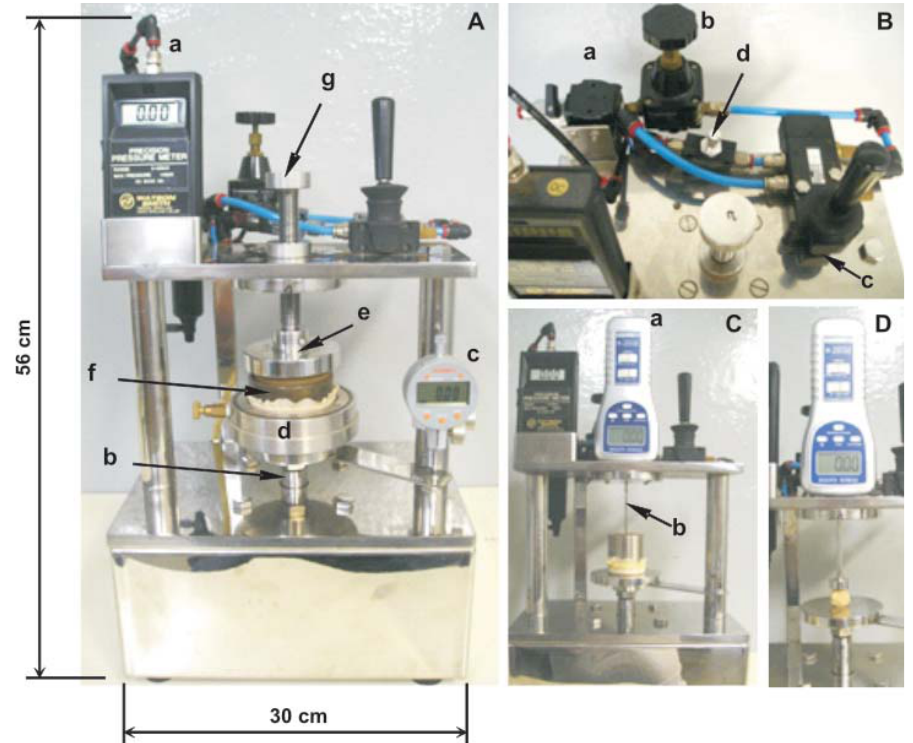
Figura 1. Consolidômetro pneumático com um corpo-de-prova (A,f) sob ensaio de compressão uniaxial. Detalhes: (A,a) manômetro; (A,b) eixo do cilindro pneumático; (A,c) indicador de deformação do corpo- de-prova; (A,d) e (A,e) suportes com as placas porosas inferior e superior, respectivamente, do dispositivo de transferência de pressão ao corpo-de-prova; (A,g) dispositivo de regulagem vertical; (B,a) filtro de ar; (B,b) válvula reguladora de pressão; (B,c) válvula de fluxo multidirecional; (B,d) válvula controladora de fluxo; (C,a) dinamômetro eletrônico; (C,b) haste para penetrometria; e (D) eixo com placa metálica plana para ensaio de resistência tênsil de